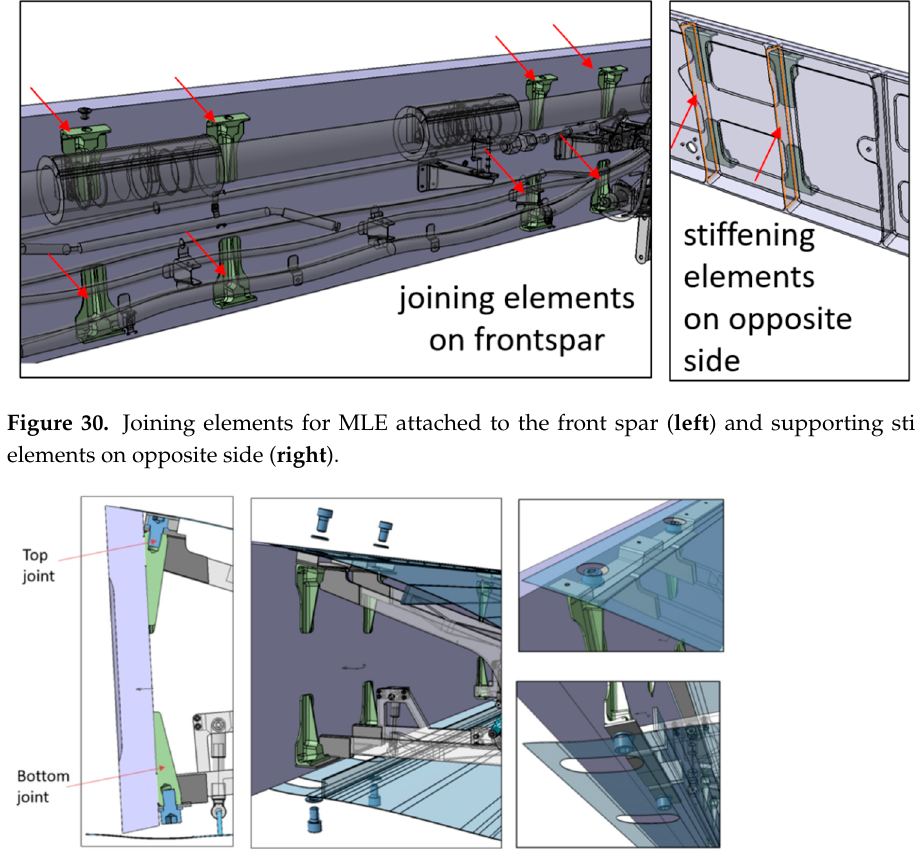
Figure 31. Bolted joint between MLE and front spar ( left ), cut-out areas at top and bottom of skin element ( right ) [28].